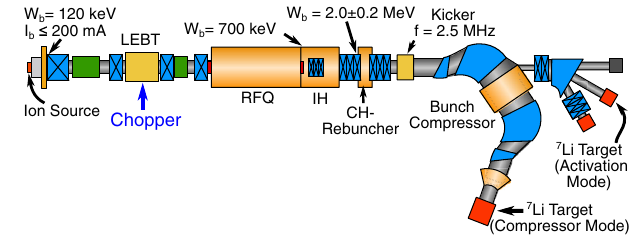
FIG. 1. Schematic overview of the Frankfurt neutron source FRANZ. The chopper is located in the center of the LEBT